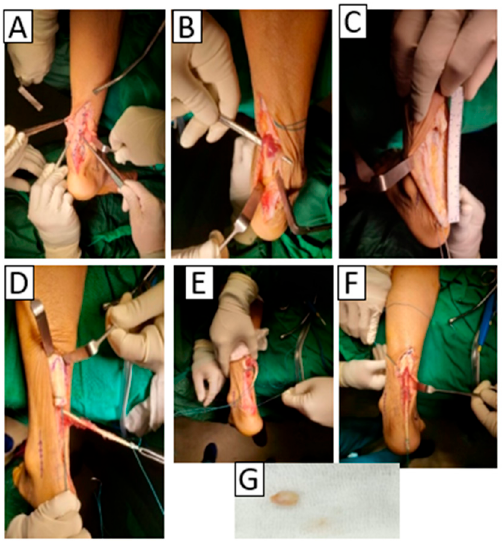
Figure 3. FHL tendon transfer and calcaneal spur reduction. ( A ) Debridement and Haglund’s deformity detection, ( B ) identification, ( C ) FHL tendon measurement, ( D ) harvesting, ( E ) augmentation, ( F ) fixation procedures, ( G ) extracted calcaneal spur.